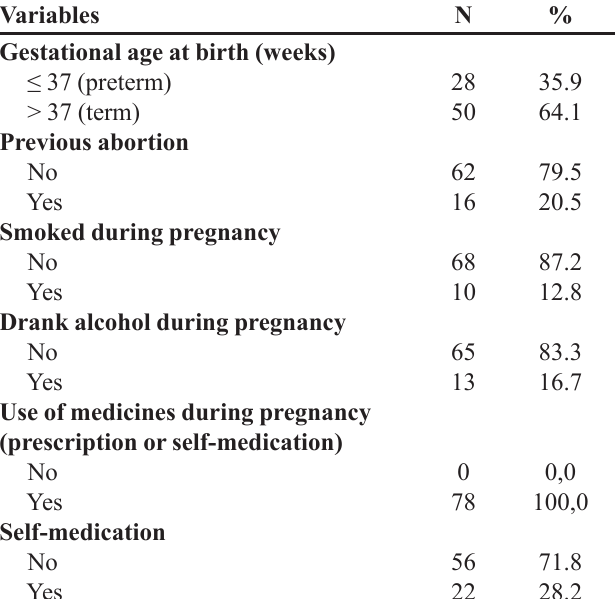
without a partner and were above 35 years of age. TABLE II – Distribution of the variables related to health issues during gestation in puerperal women interned in HC/UFPE after high-risk pregnancy,